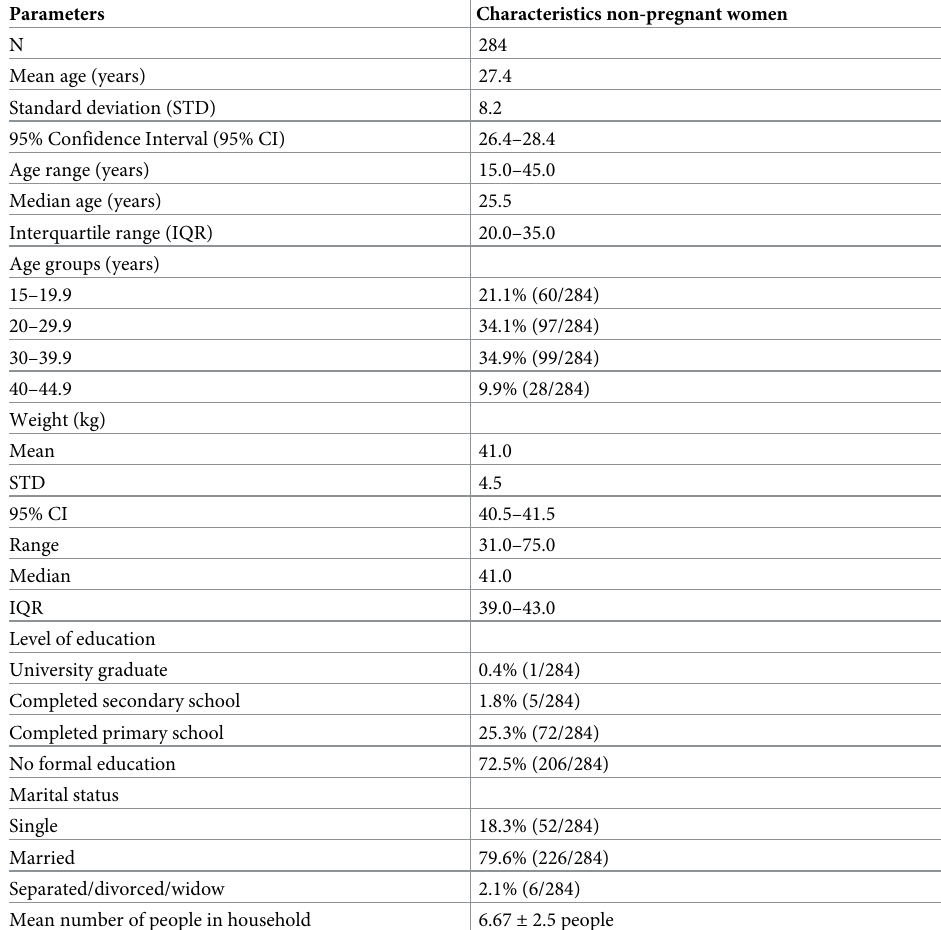
Table 1. Socio-demographic characteristics of non-pregnant women.